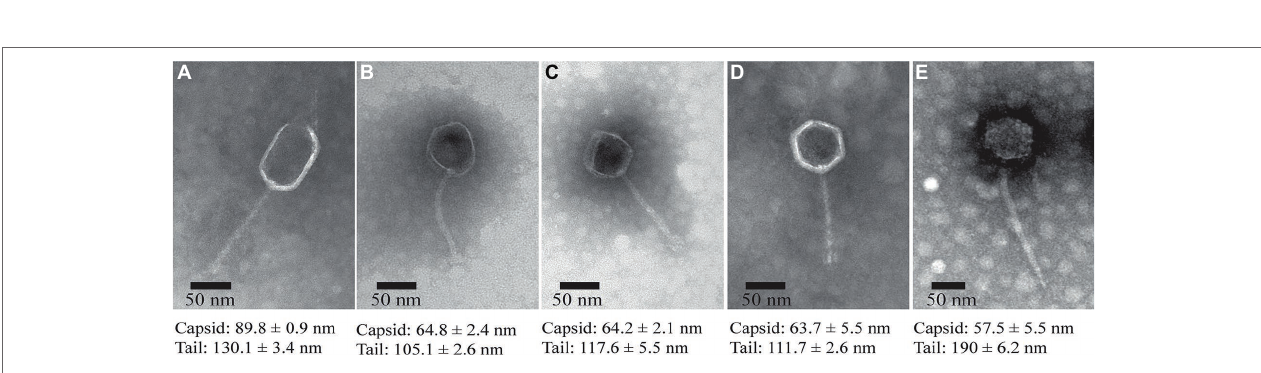
FIGURE 2 | Host ranges of phages ValLY-3, VspDsh-1, VspSw-1, VpaJT-1, and ValSw4-1. A total of 20 bacterial strains were used for determining the phage host ranges. The 16S rRNA gene sequences of all the strains have been sequenced and submitted to the NCBI with accession as attached above (more information referring to Supplementary Table S1 ). Black spots indicated clear plaque, gray for turbid plaque, and white for no phage plaque. a: The host strain used for VspDsh-1 isolation; b: VspSw-1 isolation; c: VpaJT-1 isolation; d: ValLY-3 isolation; e: ValSw4-1 isolation. *, Verified pathogenic strains in this study.